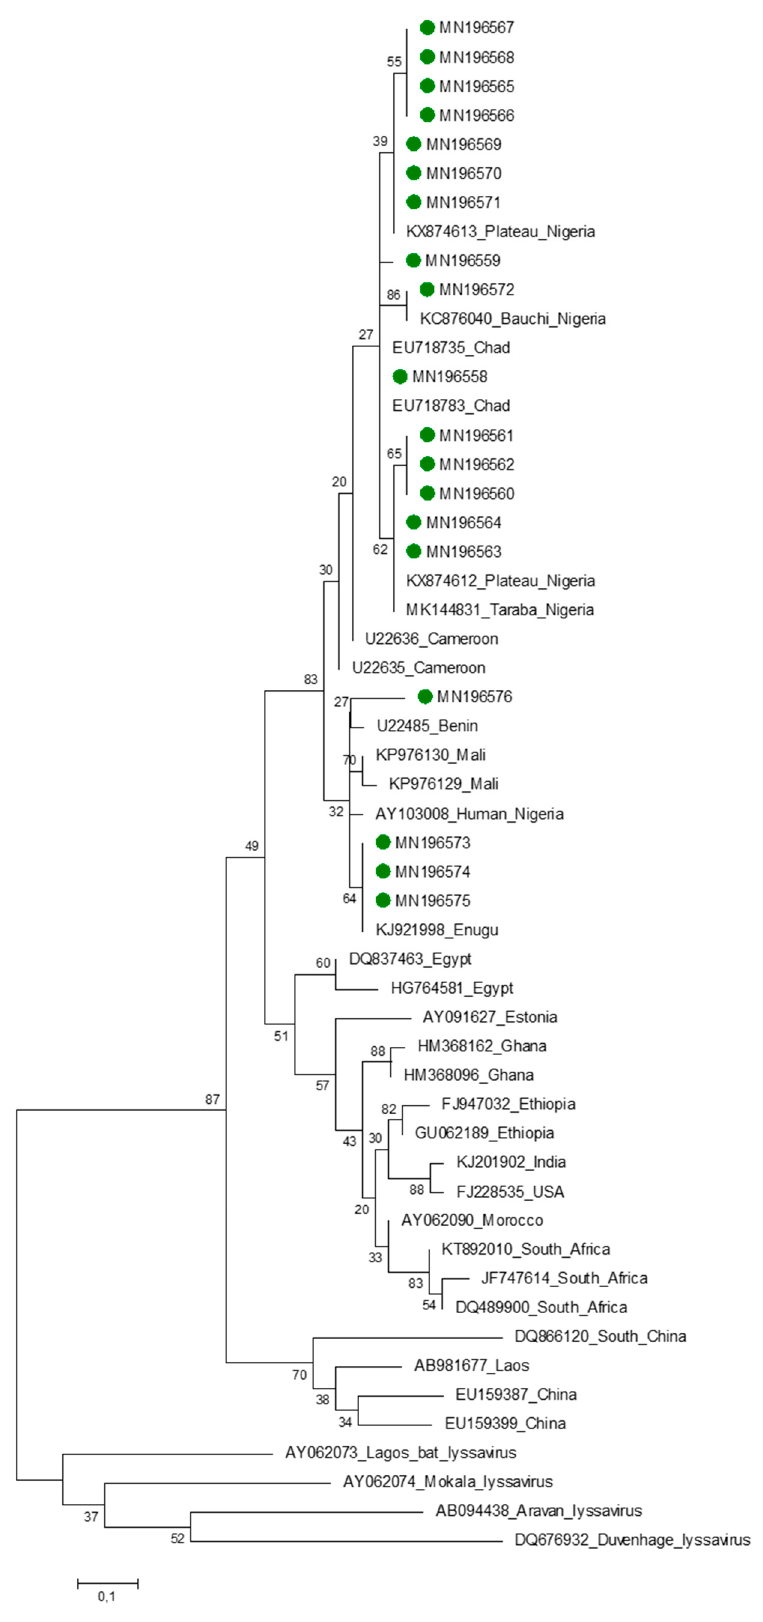
Figure 3. Maximum likelihood (ML) phylogenetic tree of the 19 Southeastern Nigerian RABV nucleoprotein deduced amino acid sequences generated using ML algorithm (1000 bootstrap replications).